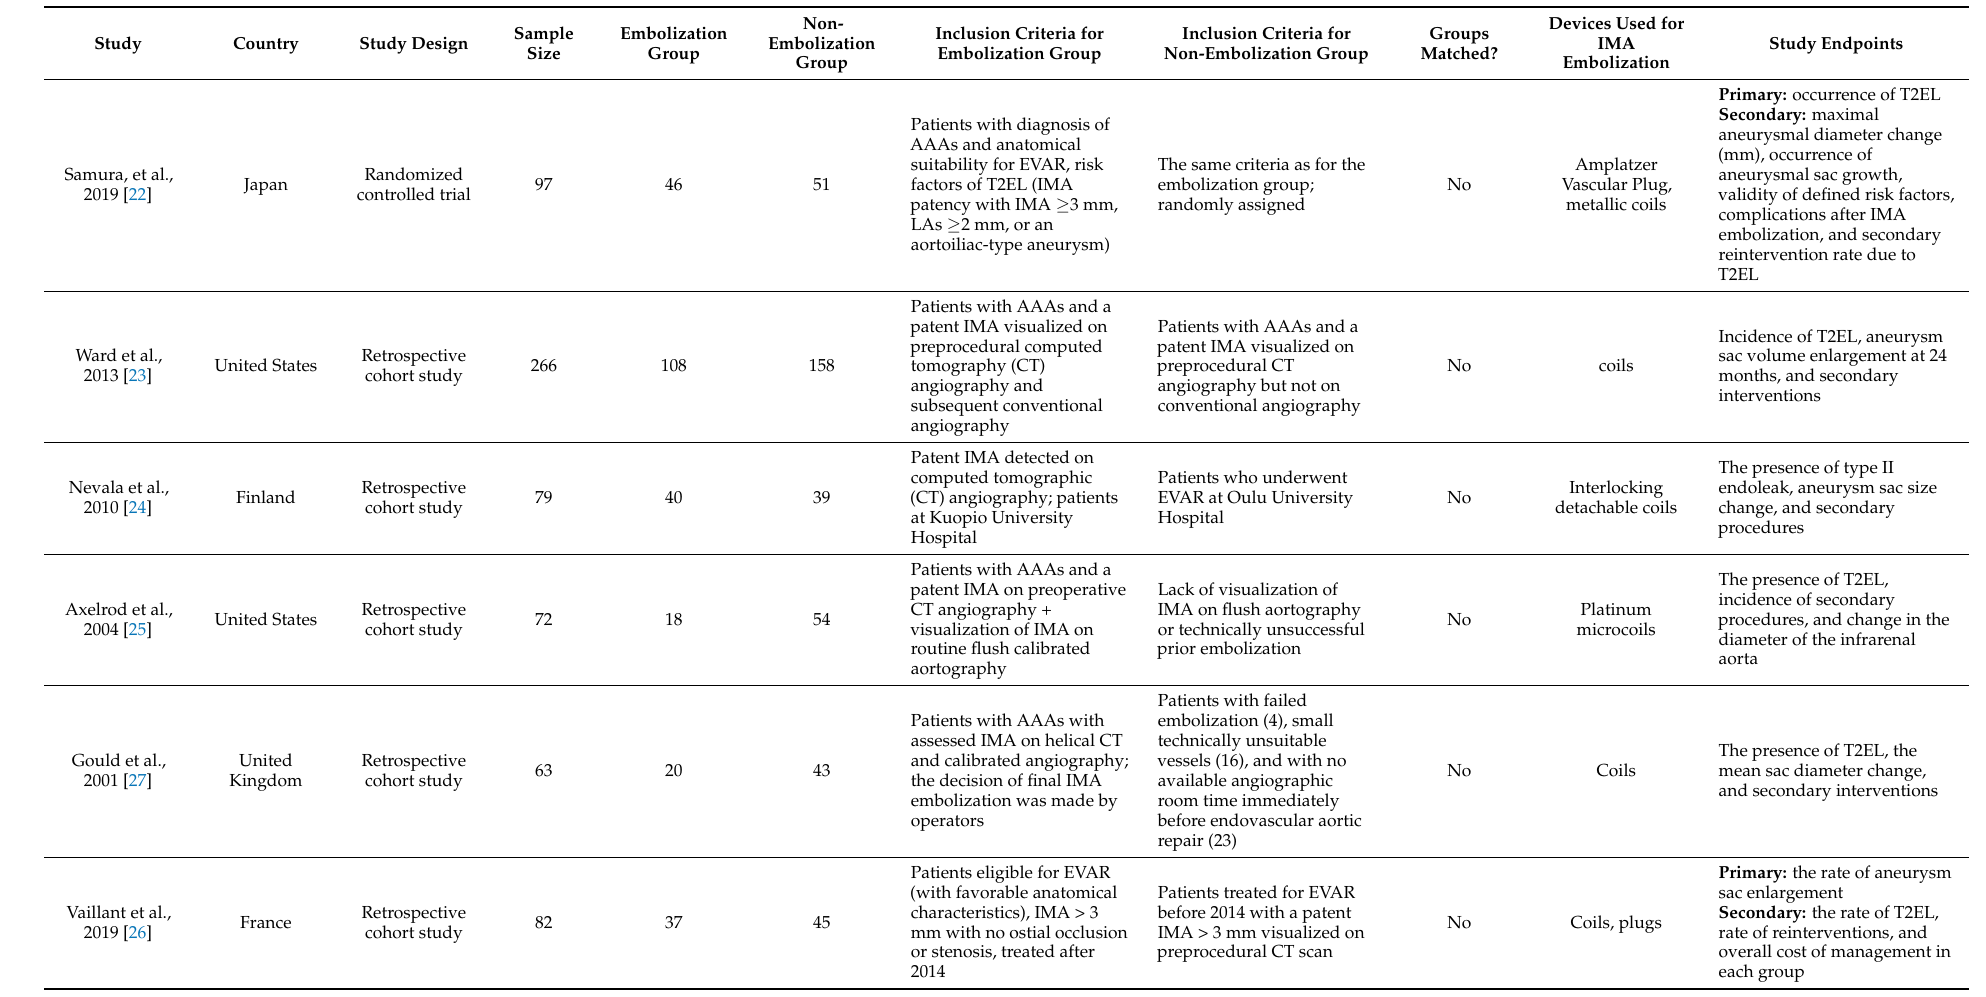
Table 3. Characteristics of Included Studies. AAA , Abdominal Aortic Aneurysm; CT , Computed